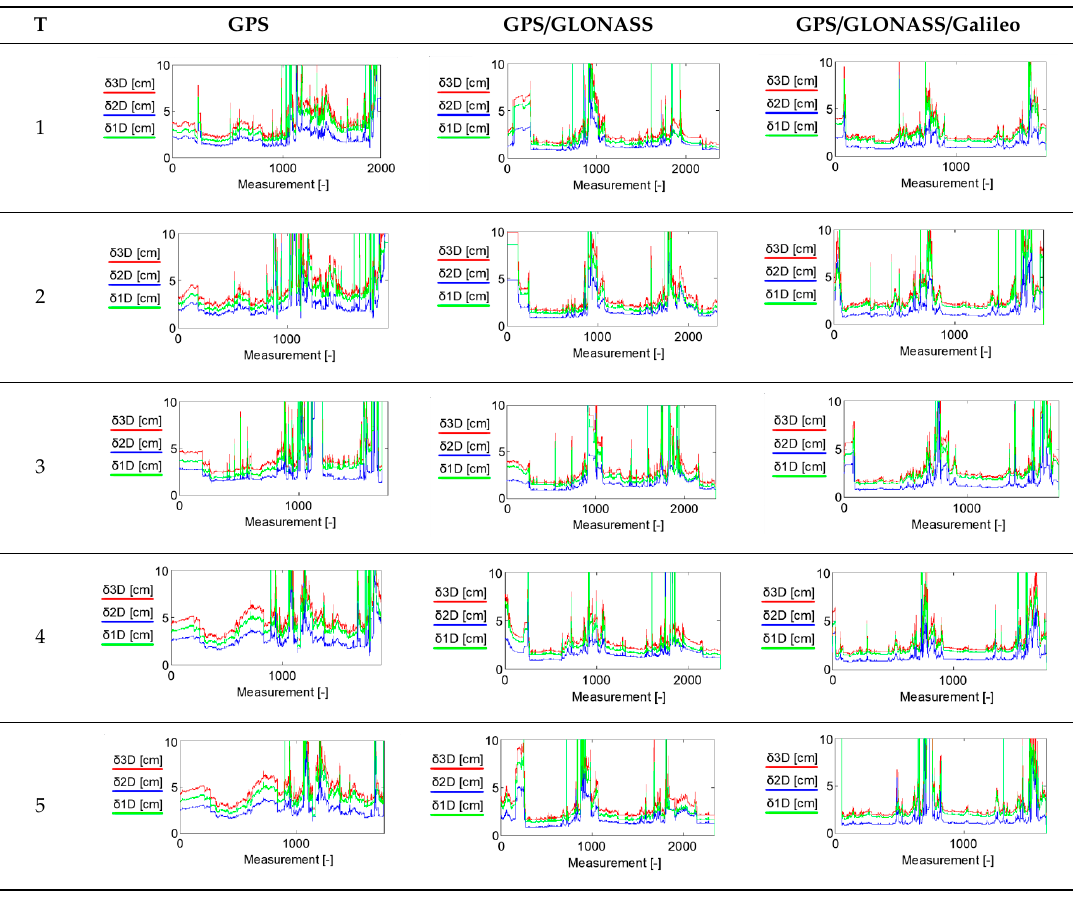
Table 9. 3D, 2D and 1D position errors recorded by five receivers of the T producer for the three GNSS solutions, GPS, GPS/GLONASS and GPS/GLONASS/Galileo.